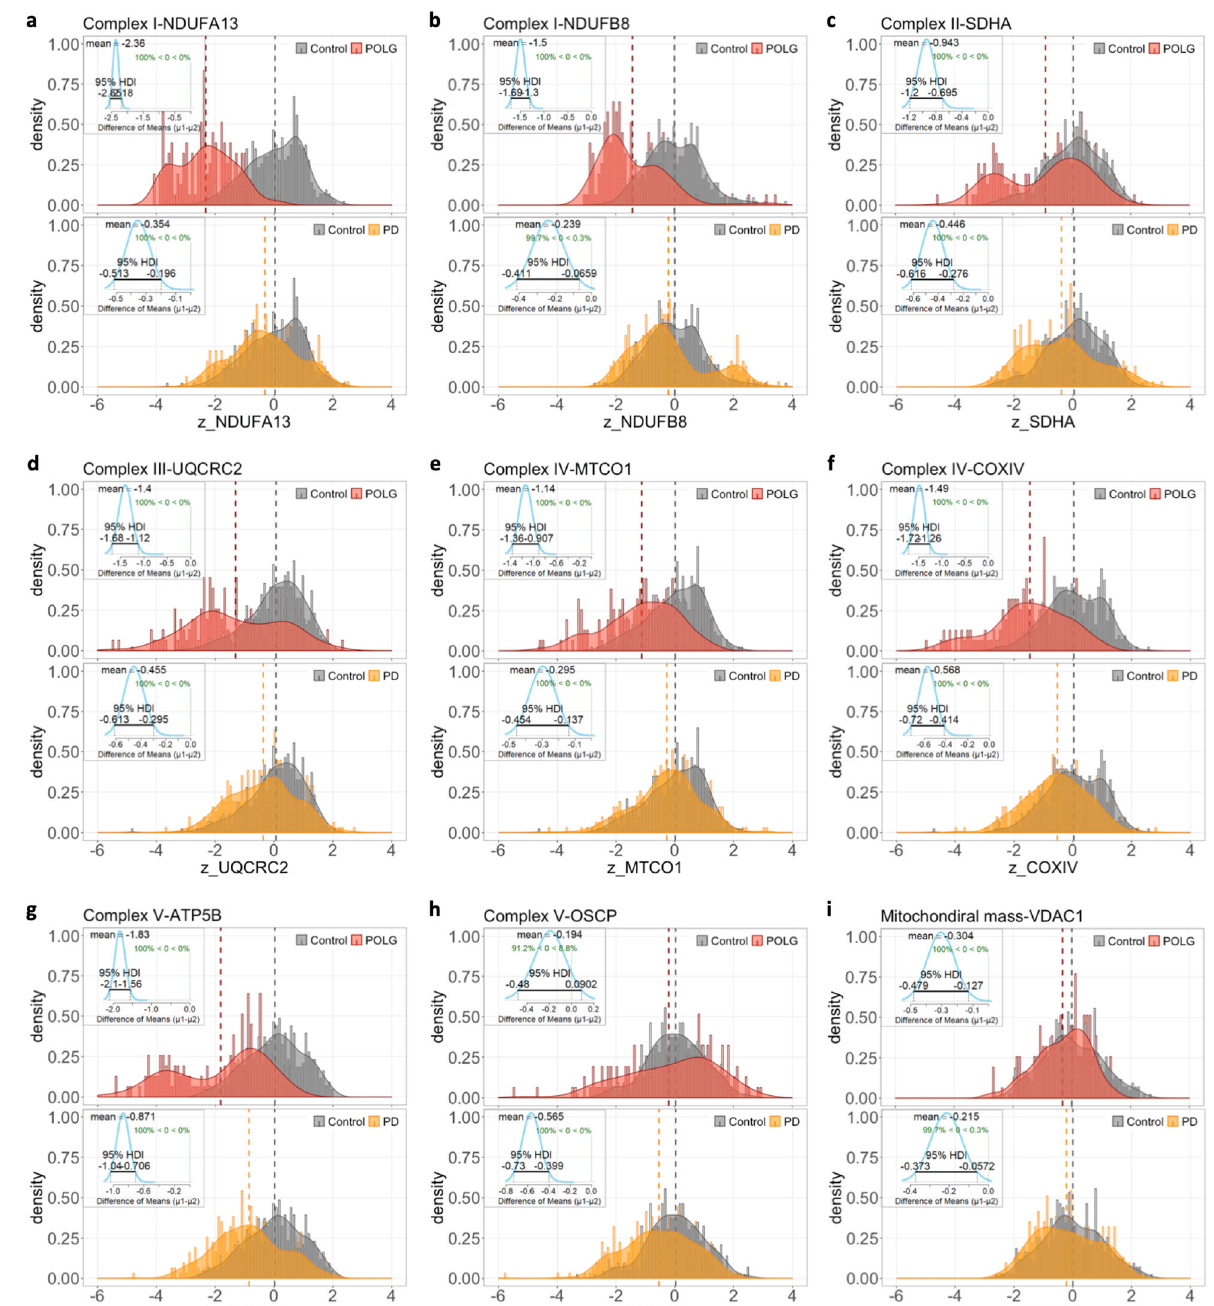
Fig. 4 Z score distribution of OxPhos protein expression in single neurons from disease and control groups. a – i Frequency histograms (bin width = 0.1) demonstrate the comparison of the z score of tested OxPhos subunits (normalised to mitochondrial mass/VDAC1) and mitochondrial mass for individual neurons in two paired groups: POLG (red) versus control (grey), and PD (yellow) versus control. Number of neurons analysed: PD, n = 313; POLG, n = 156; control, n = 432). The density curve represents the normalised distribution pattern of each group dataset; the dash line shows the mean per group. The differences between every paired dataset were statistically described using the Bayesian estimation (BEST, (Kruschke 18 )). The insert shows the distribution curve of the mean of difference ( µ1 – µ2 ; µ1 -diseased neurons, µ2 -control neurons), its mean value and the 95% Highest Density Interval (HDI) output from the BEST